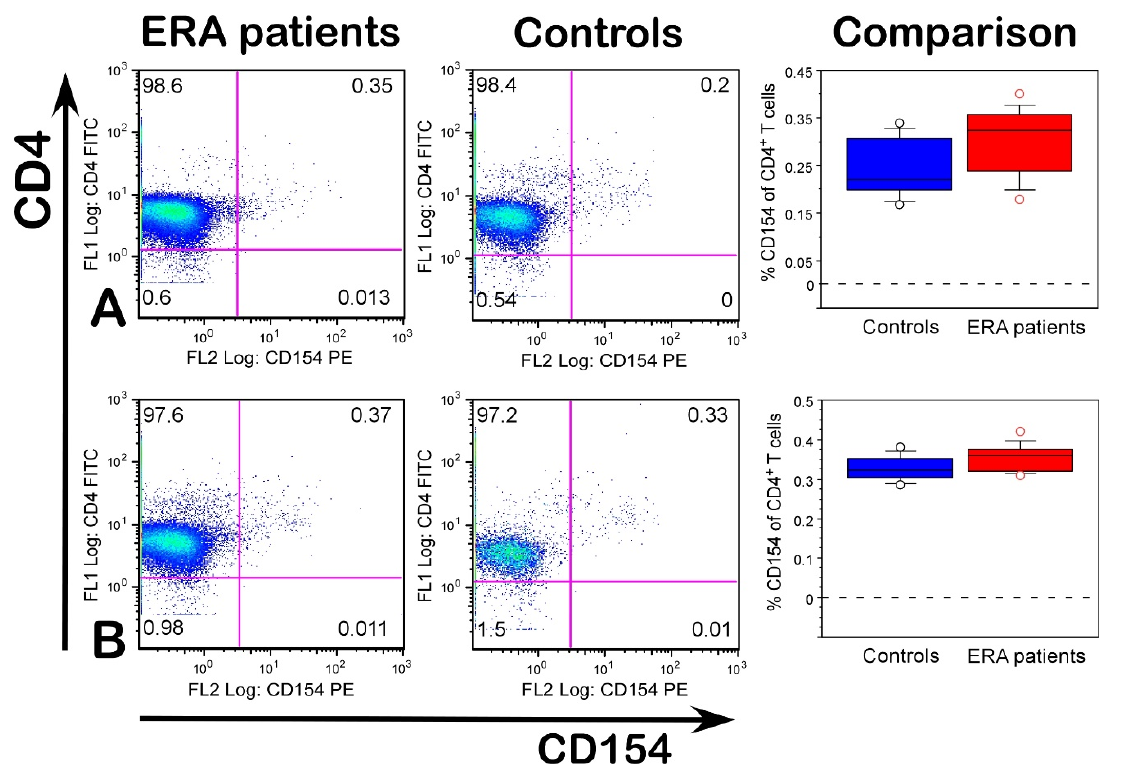
Figure 4. Percentage of CD154 + CD4 + T cells in ERA patients and healthy individuals after in vitro stimulation with huCII ( A ) and bacterial L-asparaginase ( B ). In the last column, (comparison) data are presented as means ± SE. Flow cytometry analyses were performed by using a Cytomics FC500 flow cytometer.